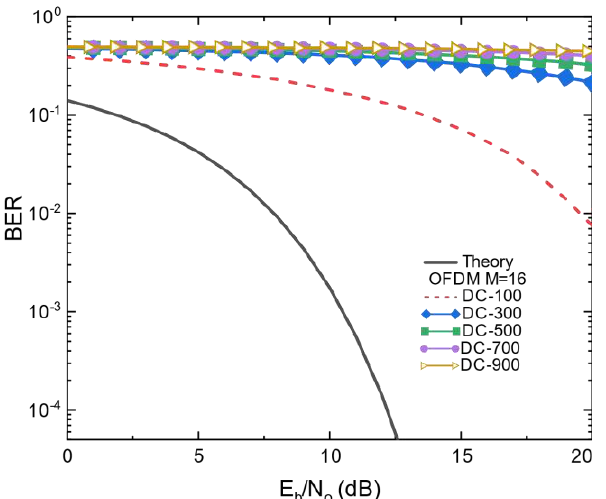
Figure 7. BER performance as a function of E b /N o for OFDM with 16-QAM and 200 AC.